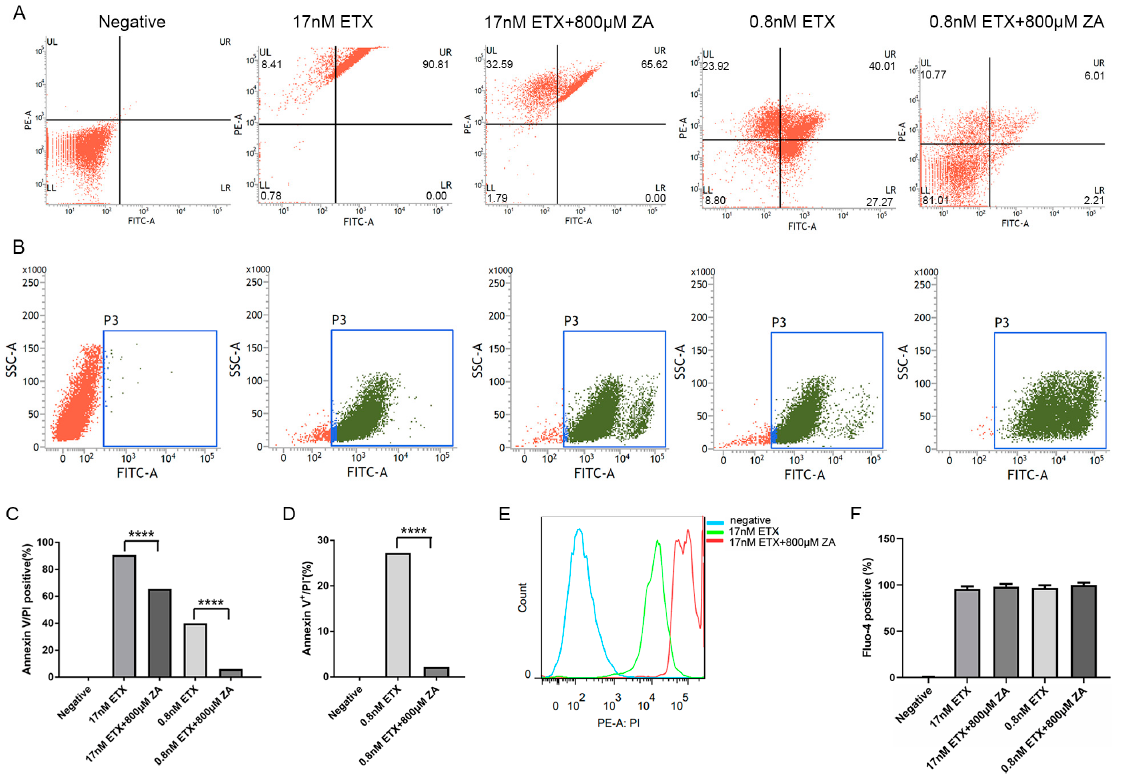
Figure 4. ZA prevents toxin-induced PS exposure but strengthens Ca 2+ influx of MDCK cells. ( A ) MDCK cells were exposed to ZA for 30 min, followed by the addition of different concentrations of GST-ETX (17 and 0.8 nM) for 1 h at 37 ◦ C. Then, cells stained by PI (PE-A channel) and annexin V (FITC channel) were analyzed on a flow cytometer. ( B ) The influx of Ca 2+ in MDCK cells was measured in a flow cytometer by incubation with fluo-4 AM (5 µ M). ( C ) Annexin V and PI-positive cells were counted and normalized to the number of total cells. ( D ) Annexin-V-positive and PI-negative cells were counted and normalized to the number of total cells. ( E ) Frequency curve of Figure 4A. ( F ) Fluo-4-positive cells were counted and normalized to the number of total cells. **** p < 0.0001.